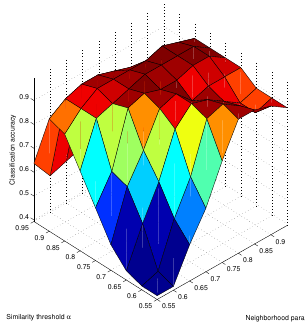
Figure 4. Classification accuracy for the wine